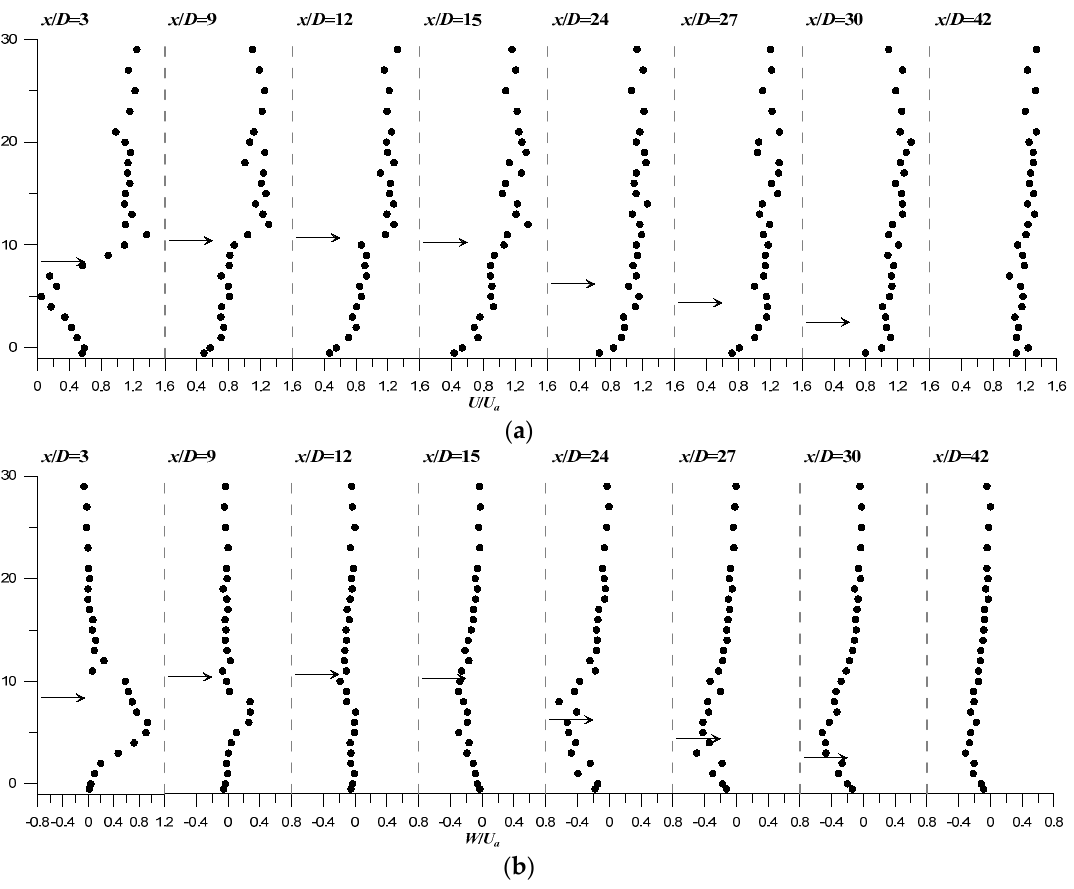
Figure 4. Normalized velocity profiles in the plane of flow symmetry ( y = 0) of run R1 at u r = 0.131 and u r F = 1.006: ( a ) U / U a ; ( b ) W / U a . The horizontal arrow on the profiles indicate the position of the jet axis.